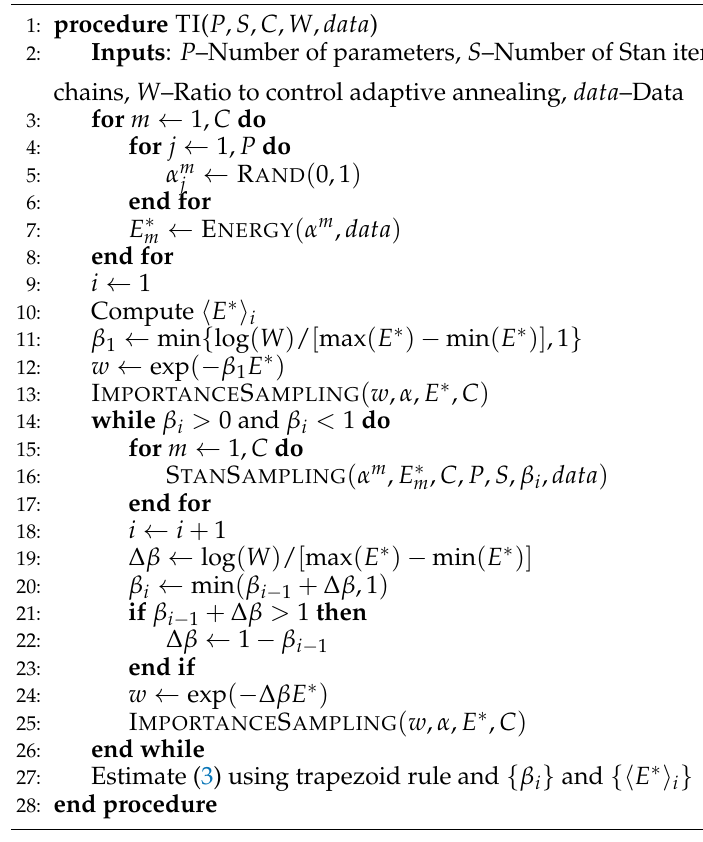
Algorithm 1 Thermodynamic integration with